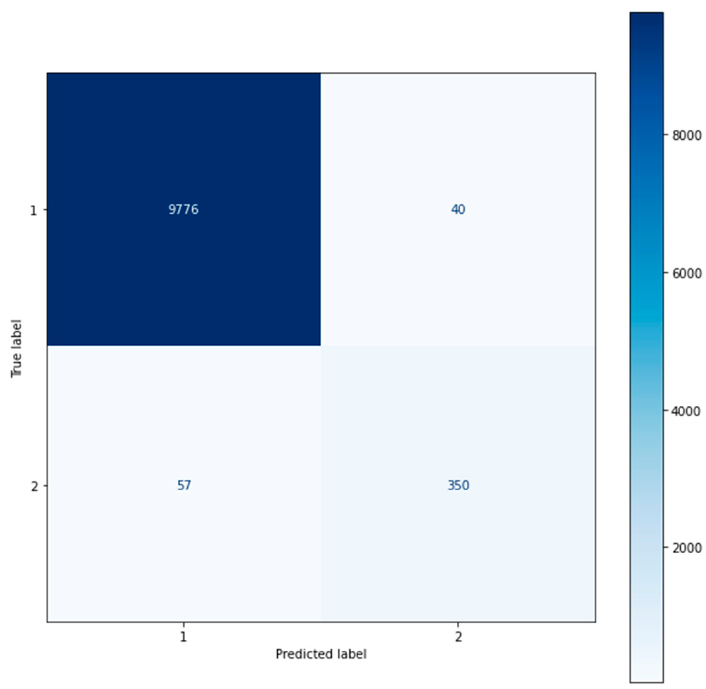
Figure 9. The confusion matrix for clicker